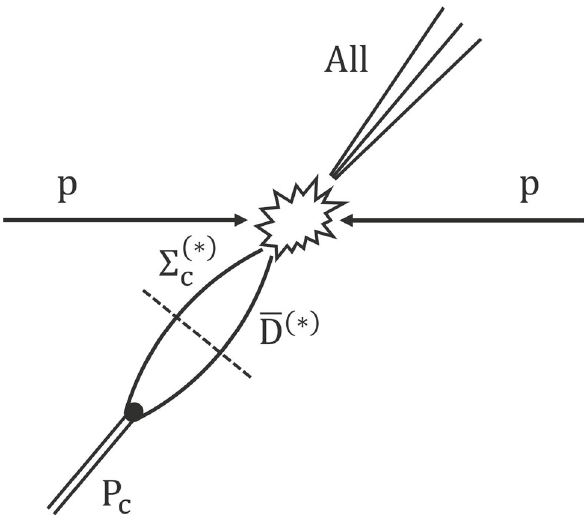
Fig. 1 The factorization of the inclusive production of hidden charm pentaquarks in pp collision in the (cid:2) The other particles produced with the (cid:2) the